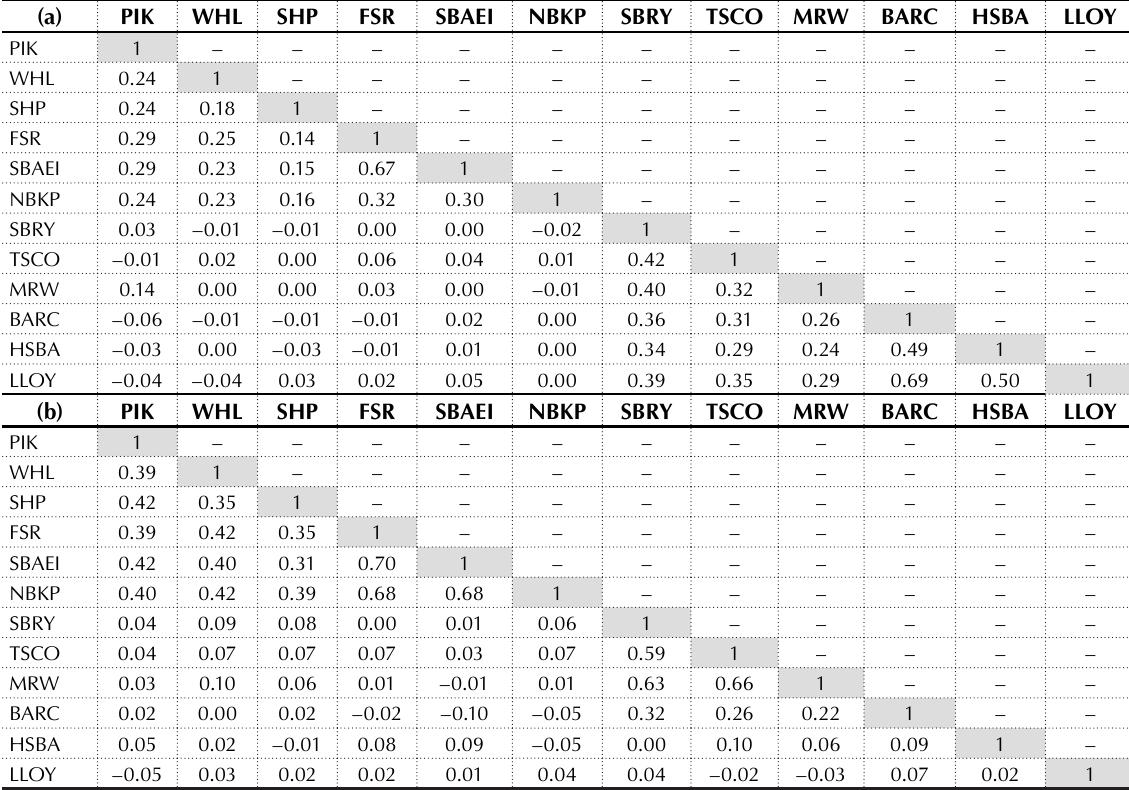
Table 2. Correlation between all securities (a) from 2003 to 2005 and (b) from 2008 to 2010 using daily returns. Demarcated areas (boxed) indicate SA securities, remainder UK